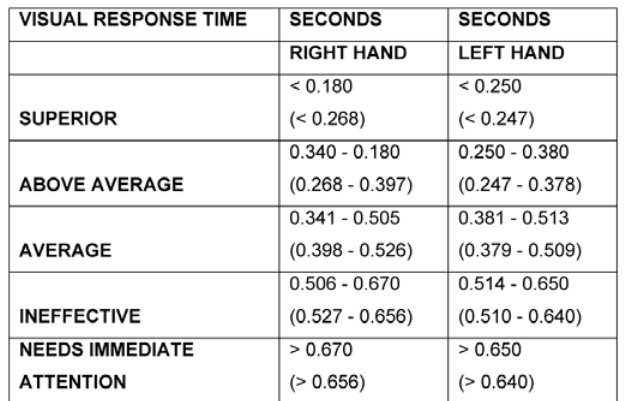
Table 6: The norms for visual response time with the use of the wayne saccadic fixator. The results in brackets are from Buys 4 .